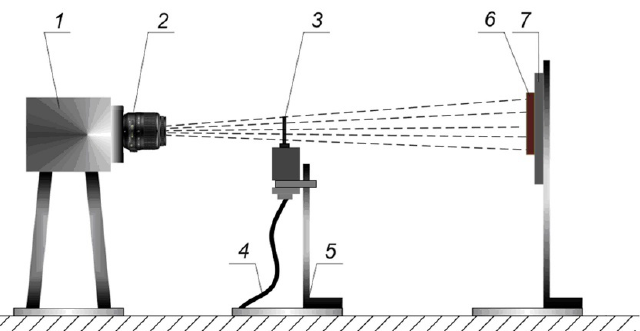
Figure 1. Sketch of the installation for obtaining the gas spectrograms: 1—light source; 2—objective lens; 3—metallizator head; 4—compressed air supply; 5—support; 6—photographic film,